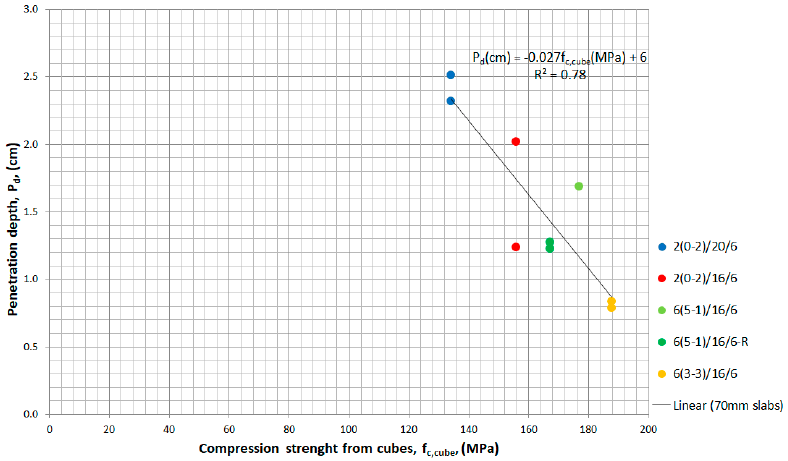
Figure 13. Correlation between penetration depth and compression strength for 70 mm thick slabs.